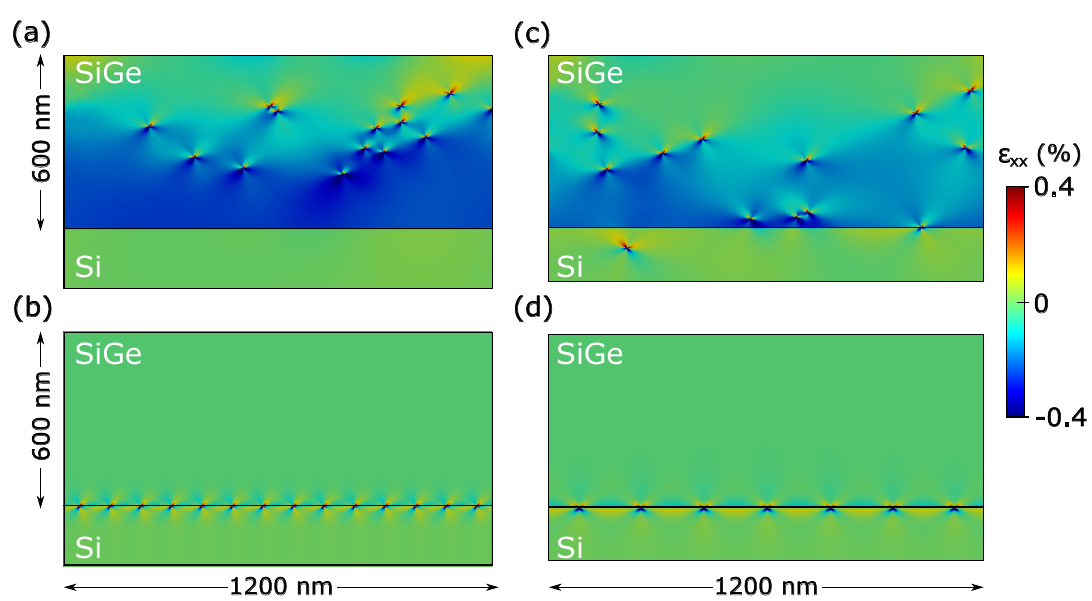
Figure 1. Minimization procedure applied to a random dislocation distribution inside a constant composition layer. Simulation plane is perpendicular to dislocation line. Starting condition of 14 dislocations with the same Burgers vector is shown in ( a ). In ( b ) the final result of the minimization shows the full relaxation of the SiGe layer with a Ge concentration of 6.25%. In ( c , d ) starting condition and final results are shown for 14 dislocations with equal distribution among the two possible Burgers vectors, coalescing into an array of 7 edge